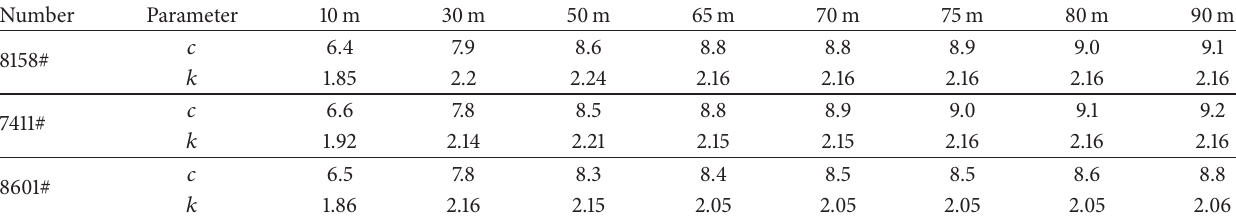
Table 4: The Weibull parameters at different heights.